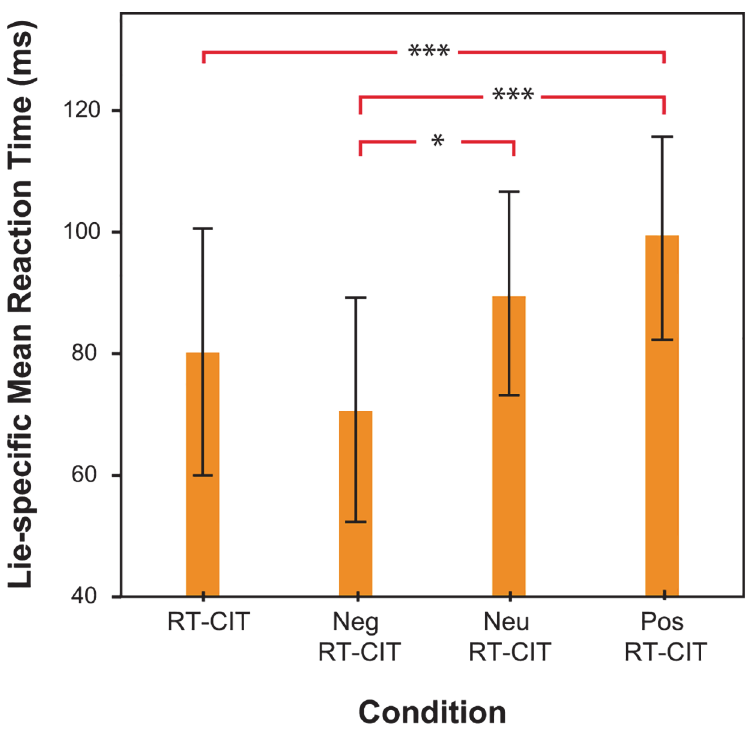
Fig 4. Lie-specific Mean Reaction Time for RT-CIT, Neg RT-CIT, Neu RT-CIT, Pos RT-CIT. Asterisks indicate significant post-hoc differences. Error bars indicate standard error of the mean ( ± 2 SEM).